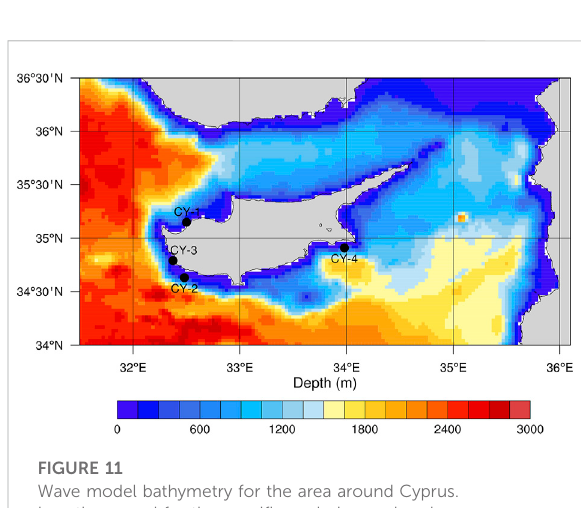
FIGURE 11 Wave model bathymetry for the area around Cyprus. Locations used for the speci fi c analysis are also